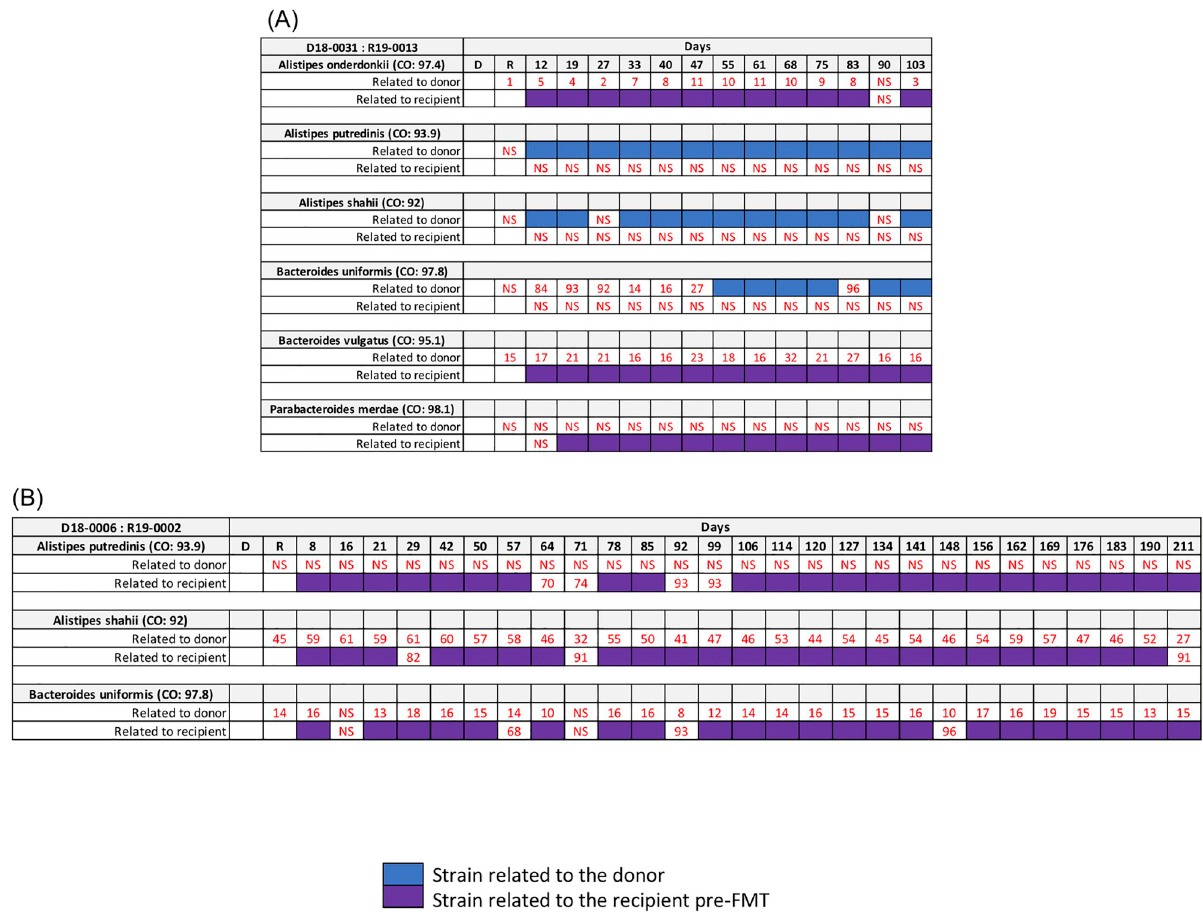
Fig 1. Summarized WSS scores from donor-recipient pairs. The WSS scores were obtained comparing 1) the donor’s sample to paired recipient’s pre- and post-FMT samples; and 2) the recipient’s pre-FMT sample to the same recipient’s post-FMT samples for (A) donor 18–0031 and recipient 19– 0013, and (B) donor 18–0006 and recipient 19–0002. All samples used for the analysis were listed in S1 Table. The summarized WSS scores per pair were grouped into different color boxes (see the figure key) or numerical numbers (when observed WSS score was below each species’ cutoff value; NS = No Score). The NS indicates the strains were unable to reliably determine relatedness due to any sample in pairs not satisfying the criteria of WSS analysis (minimum coverage > 30% and average depth > 3.5).